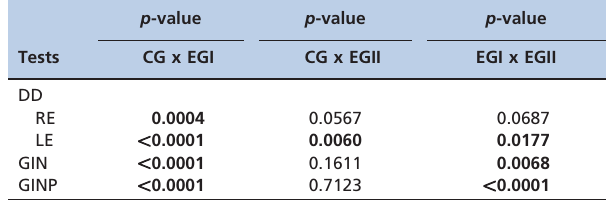
Table 3 - Student performance on the (C)AP tests between pairs of